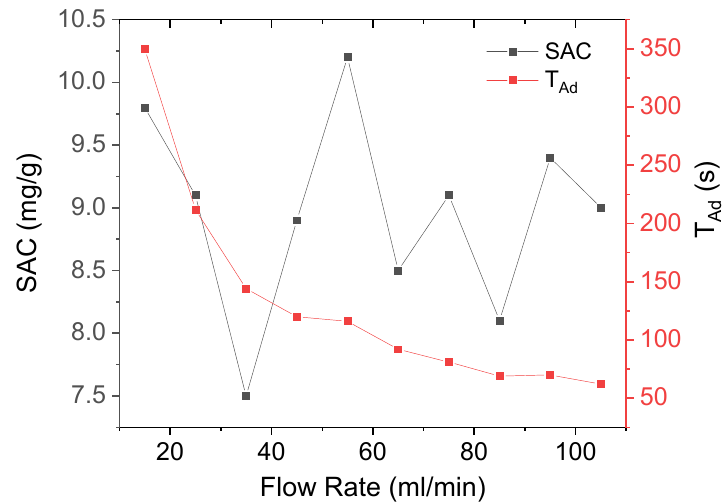
Figure 7. Variation of SAC and T AD for various flow rates (0.2 M, 1.2 V). Table 2. Comparison of SAC reported with this work.